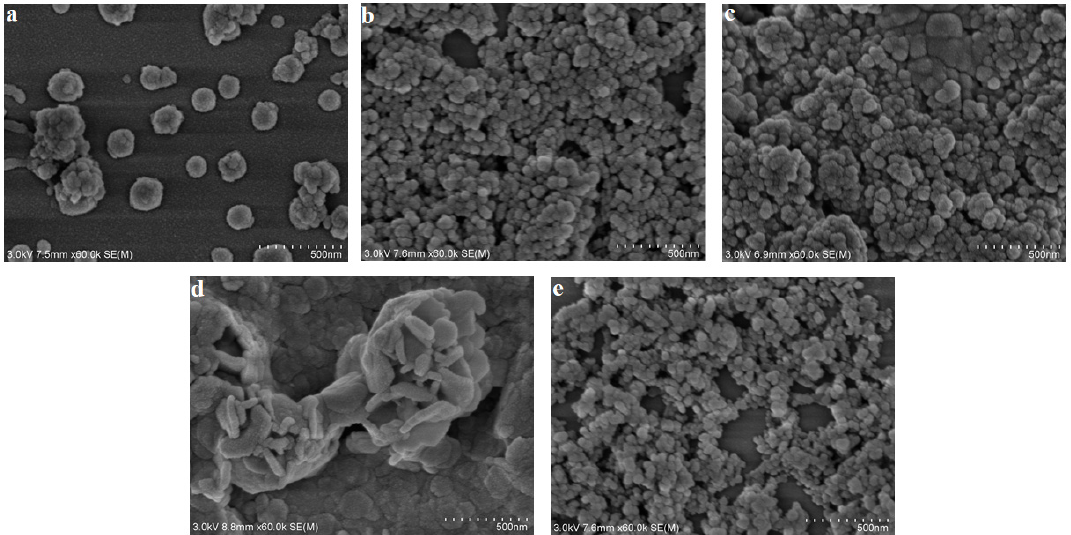
Figure 10. SEM images of adsorption effect of ( a ) γ -Al 2 O 3 , ( b ) ZrO 2 , ( c ) TiO 2 , ( d ) MgO, and ( e ) SiO 2 on oil-wet calcite.